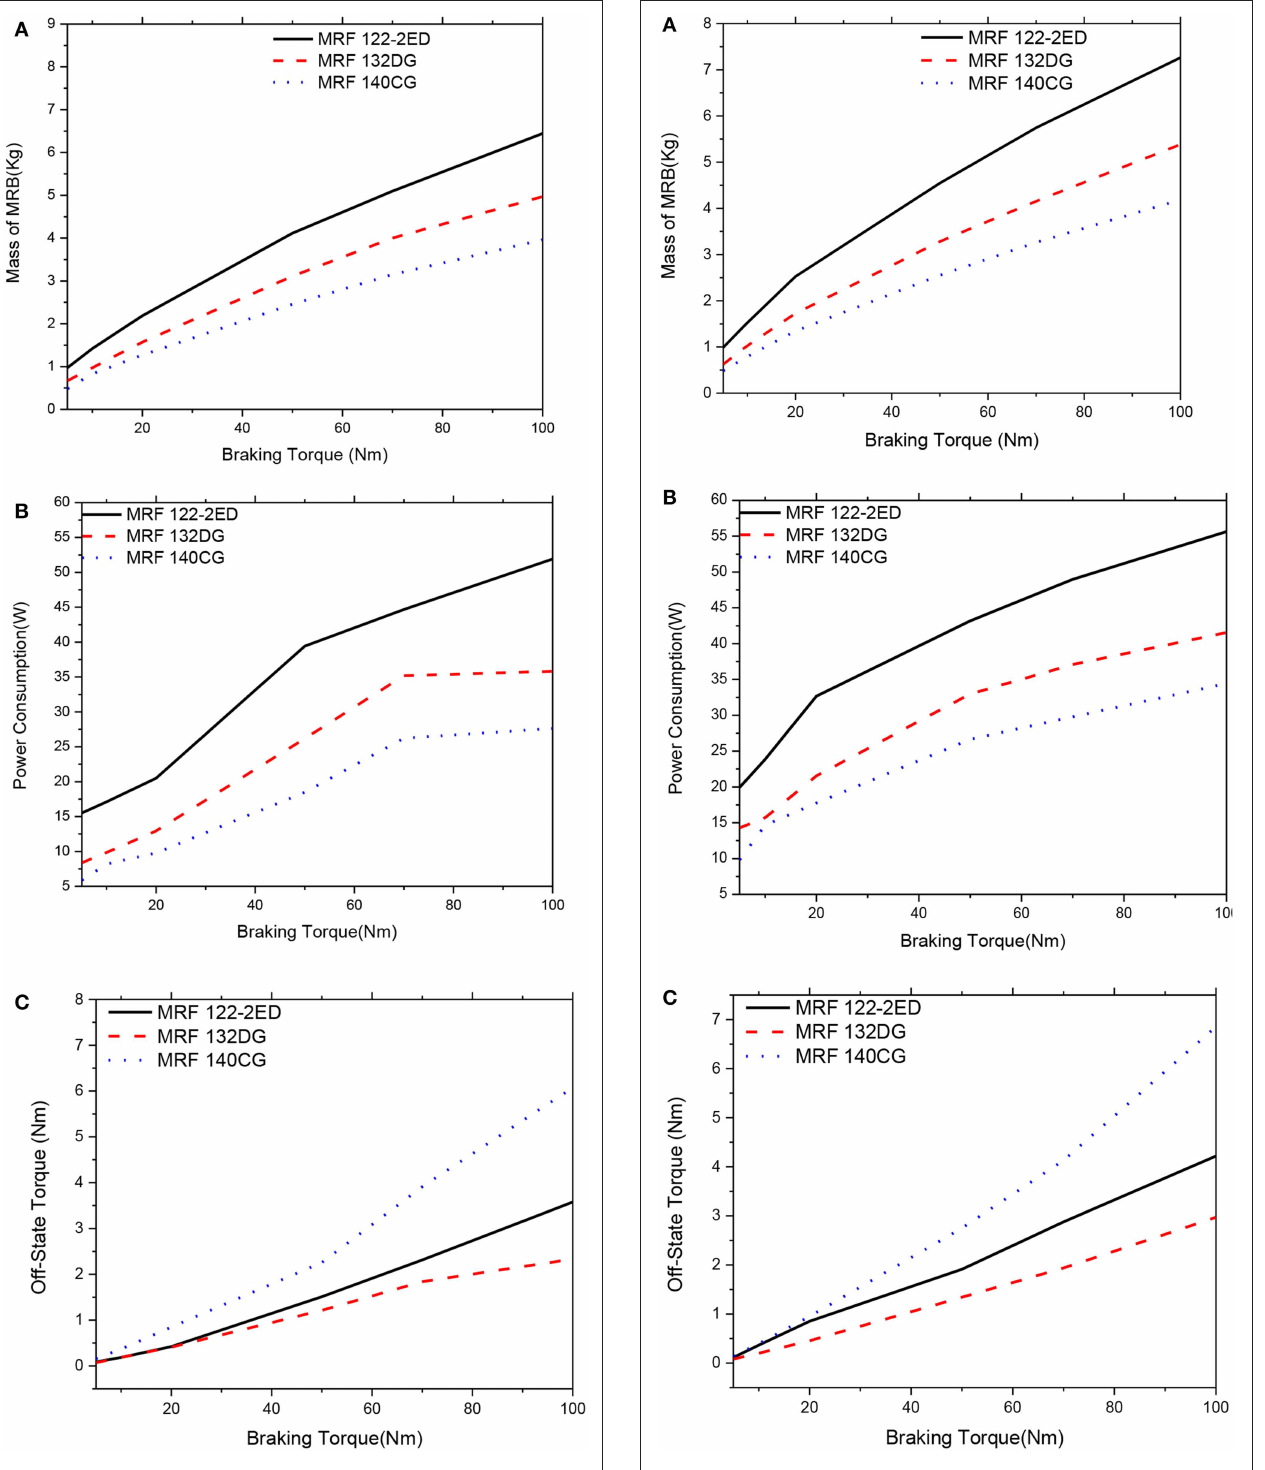
Frontiers in Materials |